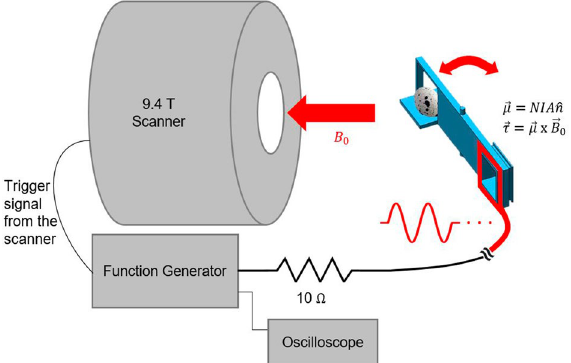
Figure 2. Experimental setup for imaging a quail egg in motion. The egg is attached to the 3D printed actuator arm which pivots with frequency defined by the function generator. Mechanical torque ( (cid:31) τ ) on the arm is generated as the cross product of the copper wire windings’ magnetic moment ( (cid:31) µ ) and the main magnetic field (cid:31) B 0 of the scanner (